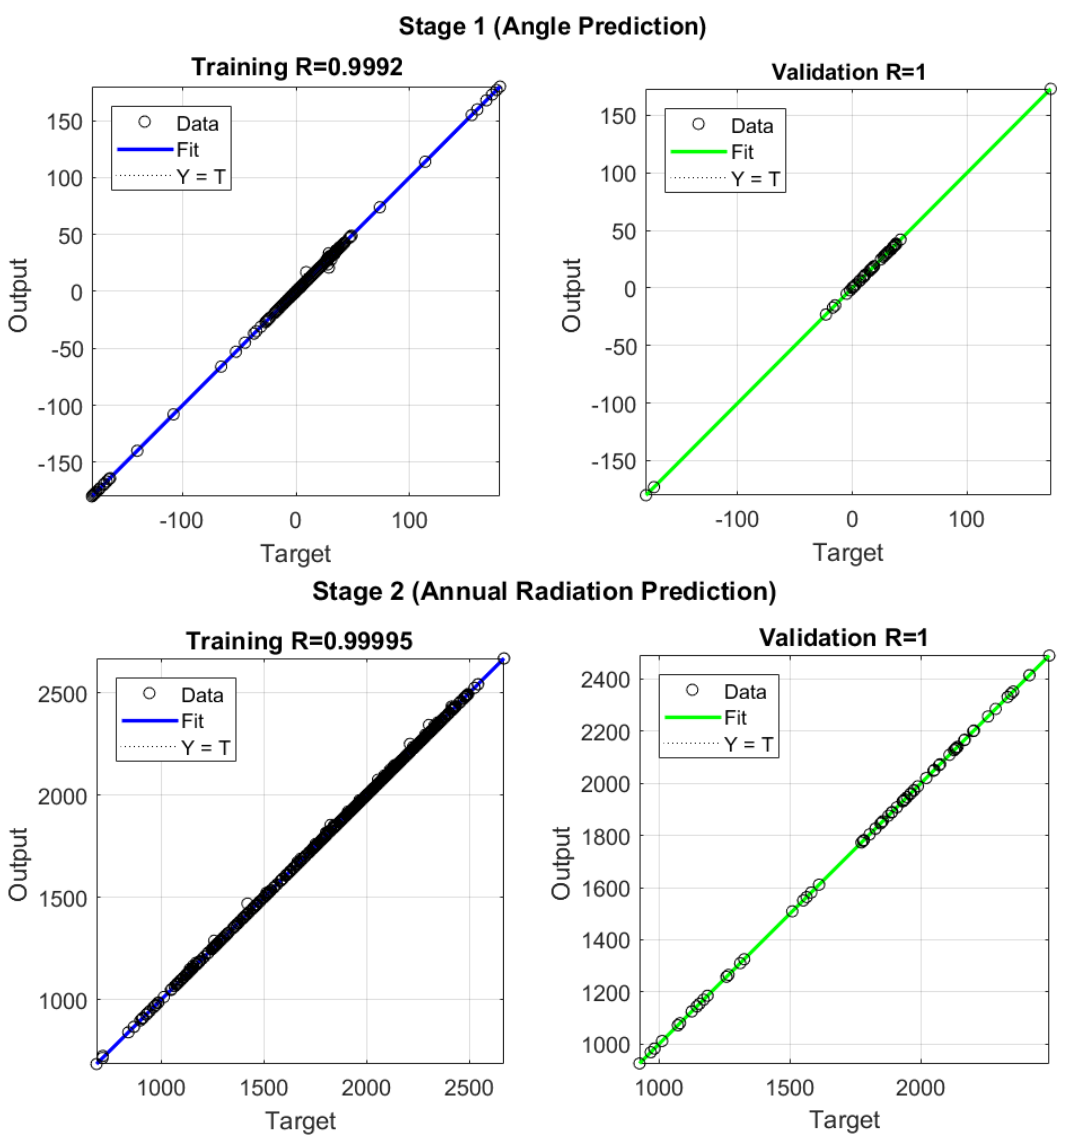
Figure 6. Regression of error for both stage 1 and 2 networks model.